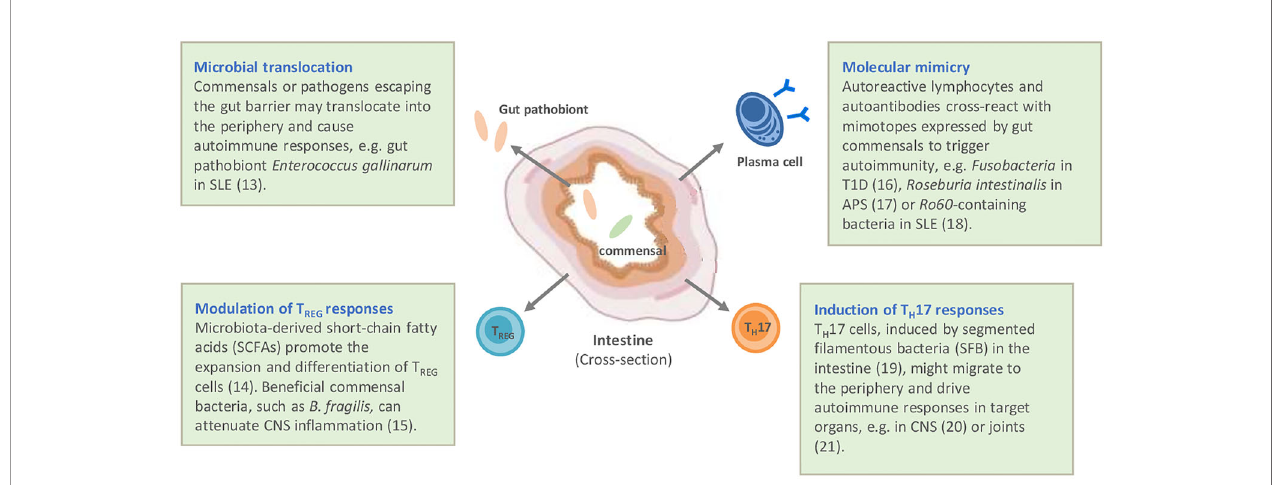
FIGURE 1 | Potential mechanisms by which autoimmune diseases are linked to gut microbiota and intestinal immunity. Modi fi ed according to (12). APS, antiphospholipid syndrome; CNS, central nervous system; SLE, systemic lupus erythematosus; T1D, type I diabetes (13 –